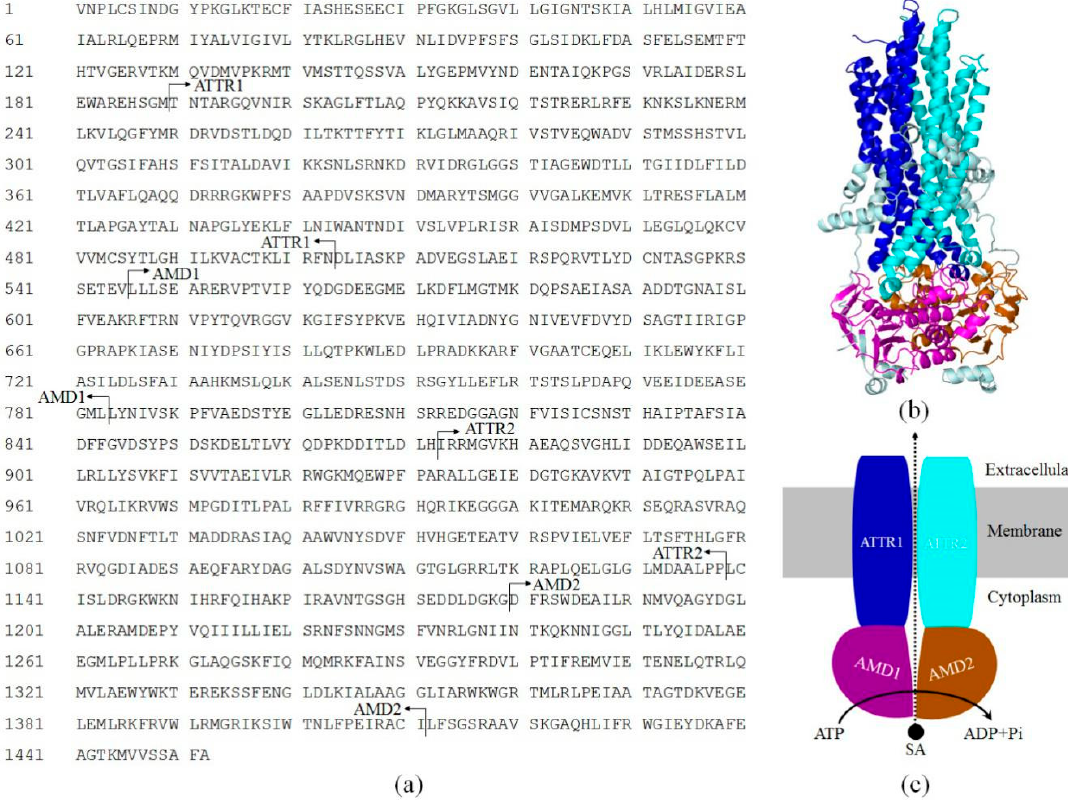
Figure A1. Structure of FgABCC9. ( a ) Distribution of conserved protein domain in the amino acid sequence of FgABCC9. ( b ) Predicted tertiary structure of FgABCC9 protein. Dark blue, purple, cyan, and brown colors indicate the “ATTR1” (ABC transporter transmembrane region 1; pfam00116; 190-503 aa), “AMD1” (ABC transporter C family MRP (multidrug resistance-associated protein) domain 1; cd03250; 546-783 aa), “ATTR2” (ABC transporter transmembrane region 2; pfam00664; 873-1138 aa), and “AMD2” (ABC transporter C family MRP domain 2; cd03250; 1180-1411 aa), respectively. ( c ) Schematic of ABC exporters